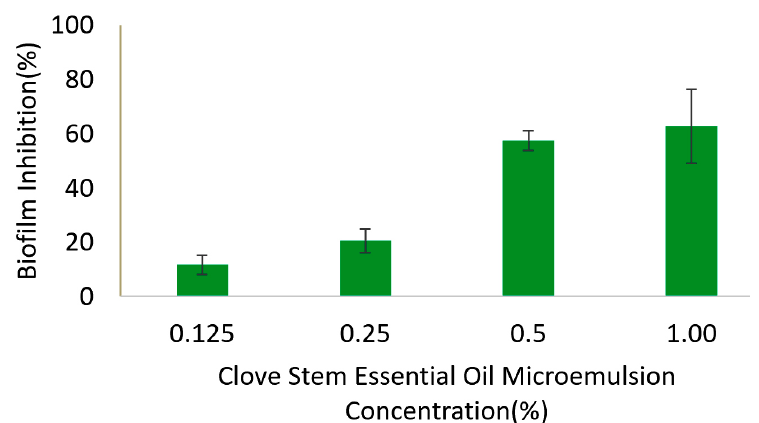
Fig. 6. MBIC value of clove stem essential oil microemulsion. MBIC50% was achieved at 1% of clove stem essential oil